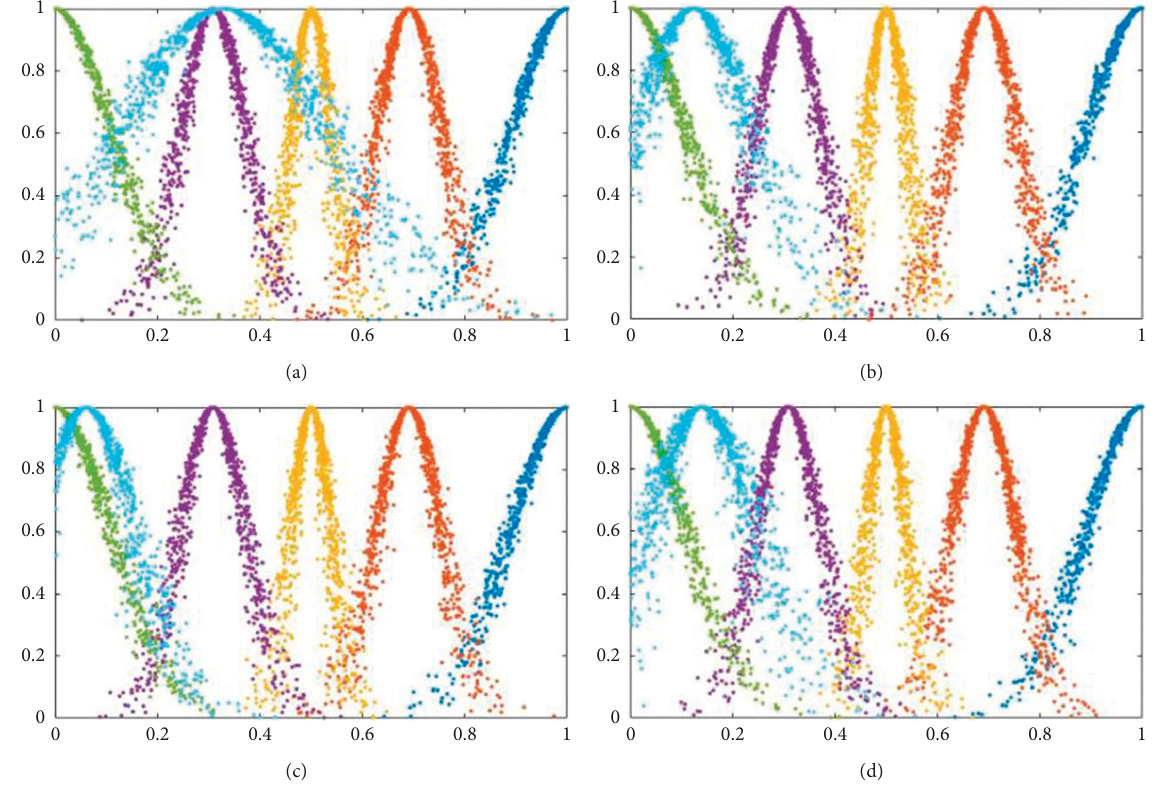
Figure 6: First level index evaluation cloud map: (a) index C 1 evaluation cloud map, (b) index C 2 evaluation cloud map, (c) index C 3 evaluation cloud map, and (d) index C 4 evaluation cloud